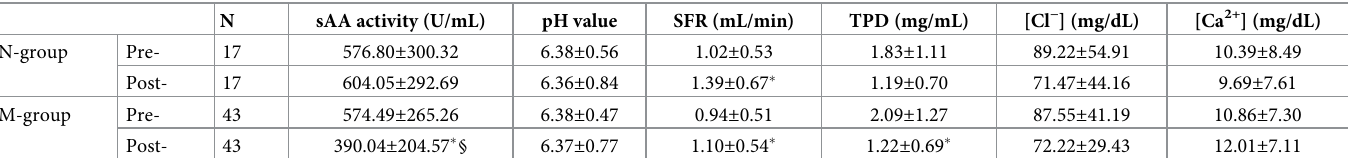
Note � p < 0.01, compared with the value at pre-acid stimulation in the same group by 2 × 2 mixed ANOVA when variances are not significantly different or by